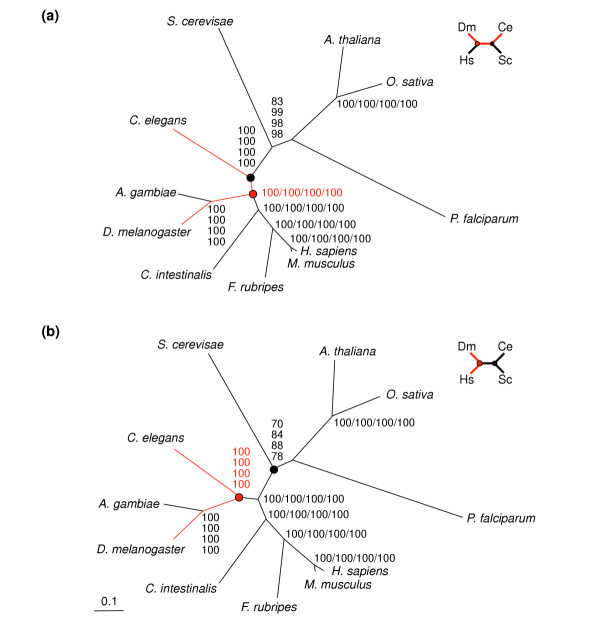
Phylogenetic trees. Trees derived from M1 and M8 datasets, respectively support (a) the Coelomata and (b) the Ecdysozoa hypothesis. From left to right or top to bottom, values besides nodes show the maximum likelihood reliability values of the quartet-puzzling tree and bootstrap values using maximum likelihood, least squares, and neighbor-joining methods, respectively. Values in red show the support for (a) Coelomata and (b) Ecdysozoa nodes. Red branches display distances between C. elegans and D. melanogaster. Smaller trees are minimal representations of both hypothesis.